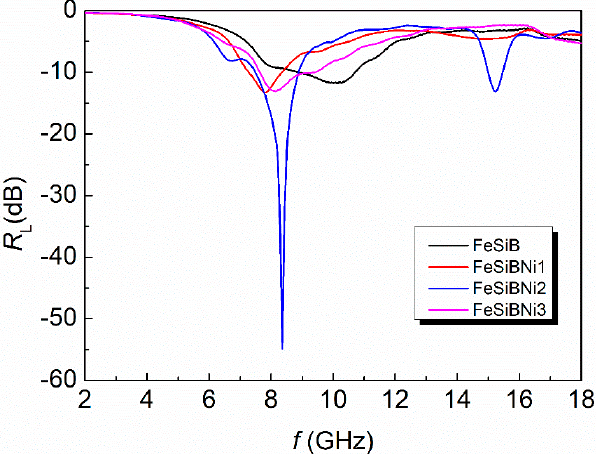
Figure 8. Frequency dependence of reflection loss of as–prepared Ni–doped Fe–based metallic mi- crowires/paraffin matrix composites at 2–18 GHz. microwires/paraffin matrix composites at 2–18